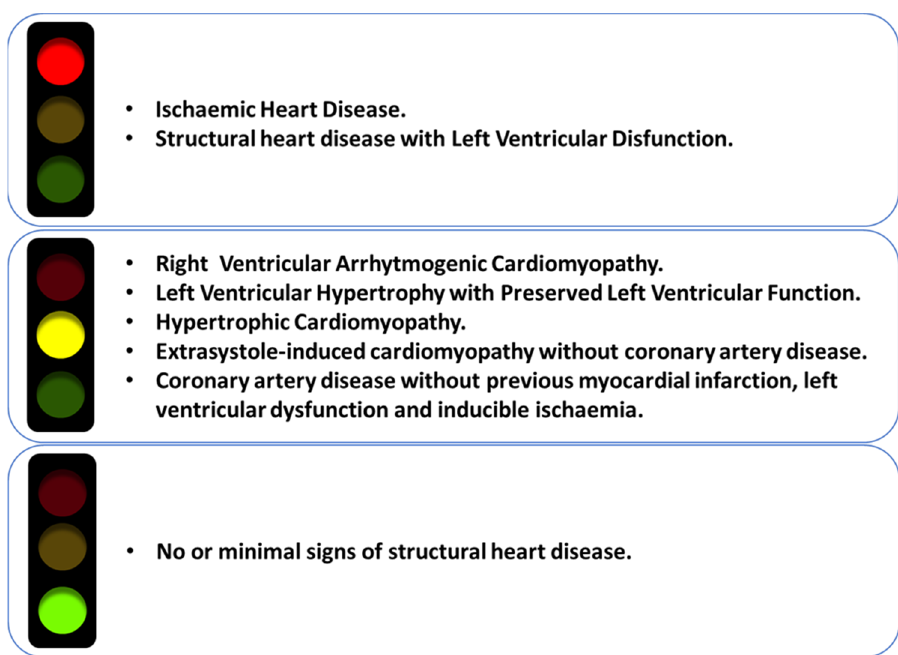
Figure 4. Current evidence on the use of flecainide. Red light: Flecainide is contraindicated. Yellow light: Flecainide may be used in these patients, but further studies are needed. Green light: Flecainide is recommended.